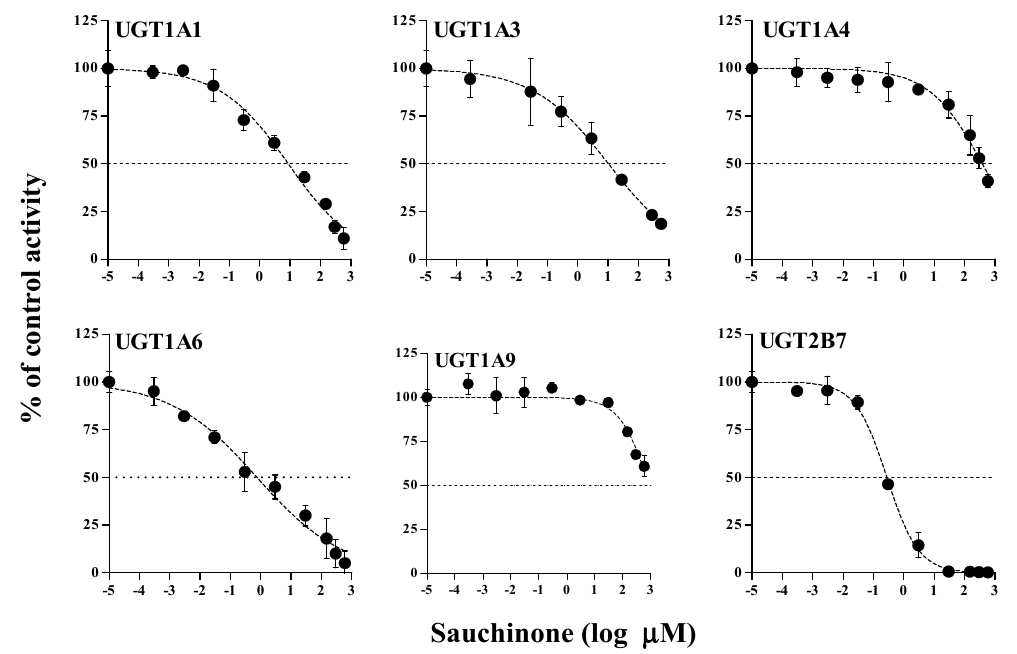
Figure 1. IC 50 curves for the direct inhibition of UGT1A1, UGT1A3, UGT1A4, UGT1A6, UGT1A9, and UGT2B7 in HLMs. The ‘ ● ’ represents the remaining percentage of UGT-mediated metabolic activity with sauchinone as an inhibitor versus control (without sauchinone). ( n = 3 for each group).